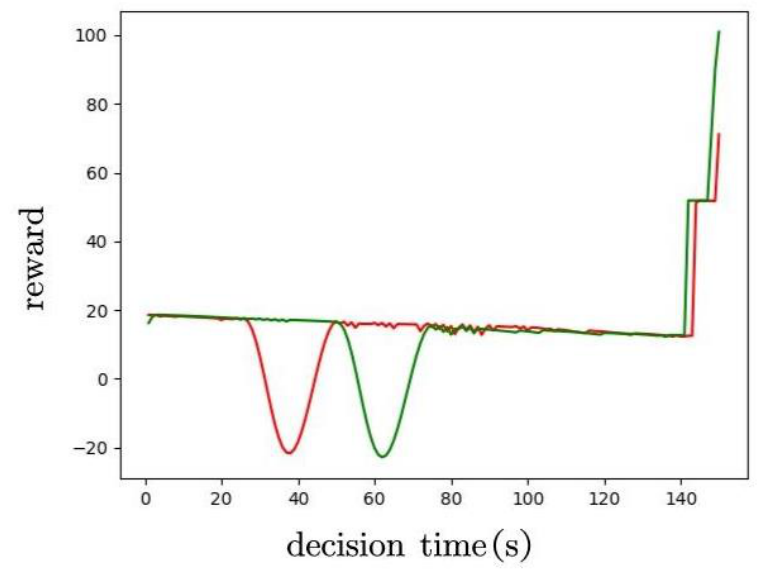
Figure 8. Change of the single step reward in the process of air